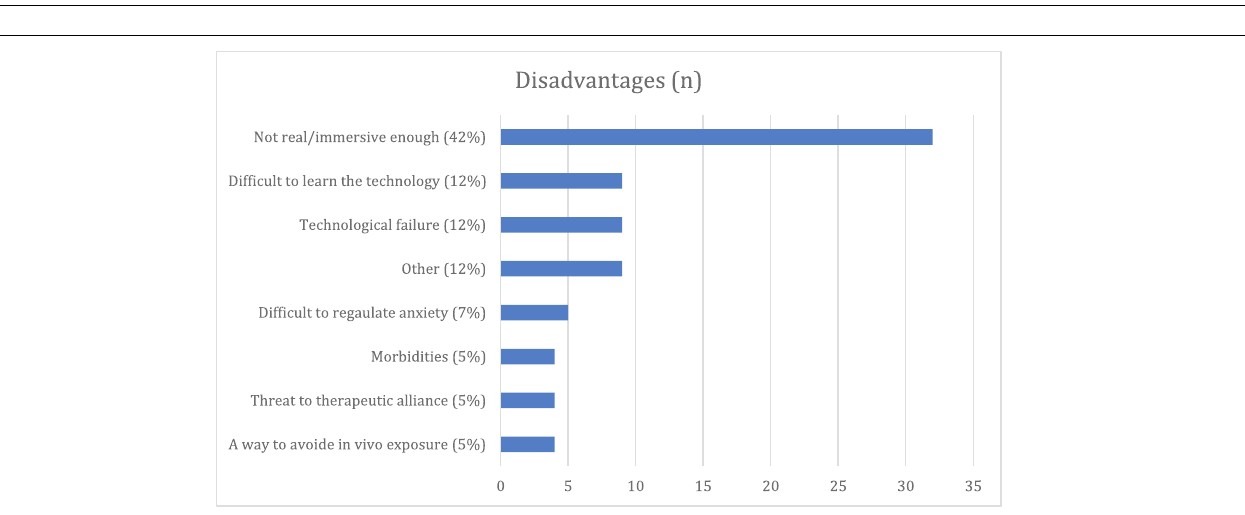
FIGURE 4 | Clinicians’ perceived advantages of using VR in therapy before the intervention. Accessibility, easy implementation and accessibility of different scenarios and stimuli without having to move out of the therapist office; Motivational and engaging, lower dropout rates, more engaging for youth and adolescence, gamification; Resource efficient, can be done solely by the therapist with no need to procure in vivo anxiety evoking stimuli; Time efficient, saving time by not having to seek out anxiety evoking stimuli. More time in therapy and less time spent on arranging exposure experiments; Economical, no expenses regarding in vivo exposure stimuli (e.g., airplane tickets, dental appointments, etc.) and reduced time related expenses; Control, all variables can be manipulated by clinicians and a greater degree of patient agency (e.g., the HMD can be removed at any time); Other, a residual category for items with low frequency of occurrence; relaxation